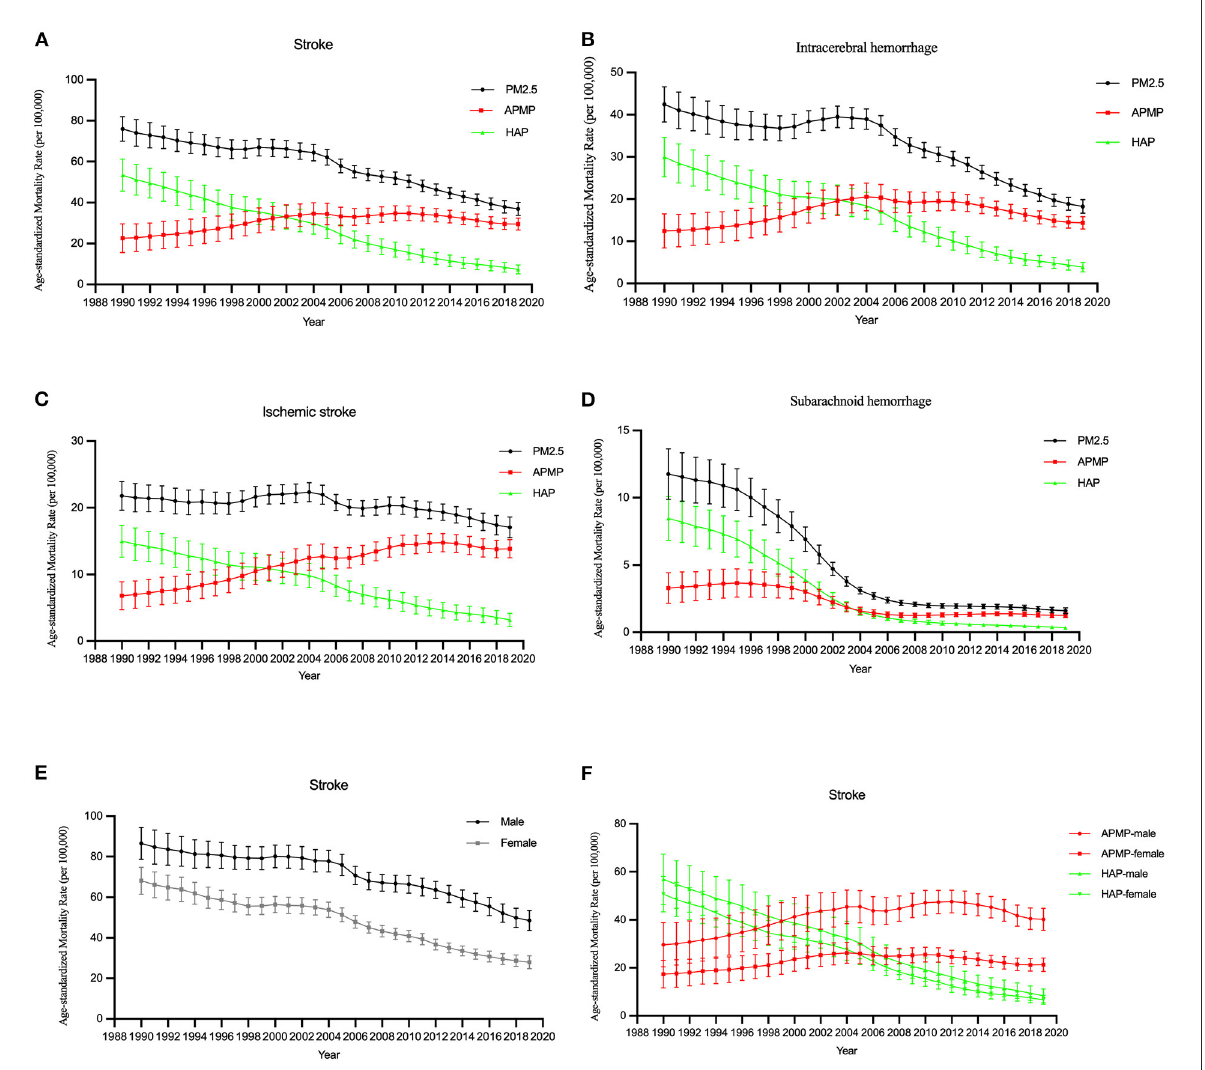
FIGURE1 The temporal trends in the ASMR of stroke attributable to PM2.5 exposure from 1990 to 2019. (A–D) The mortality rate of stroke and subtypes due to PM2.5 exposure, ambient particulate matter pollution, and household air pollution for both sexes. (E) The mortality rate of stroke due to PM2.5 exposure by sex. (F) The mortality rate of stroke due to ambient particulate matter pollution (APMP) and household air pollution (HAP) by